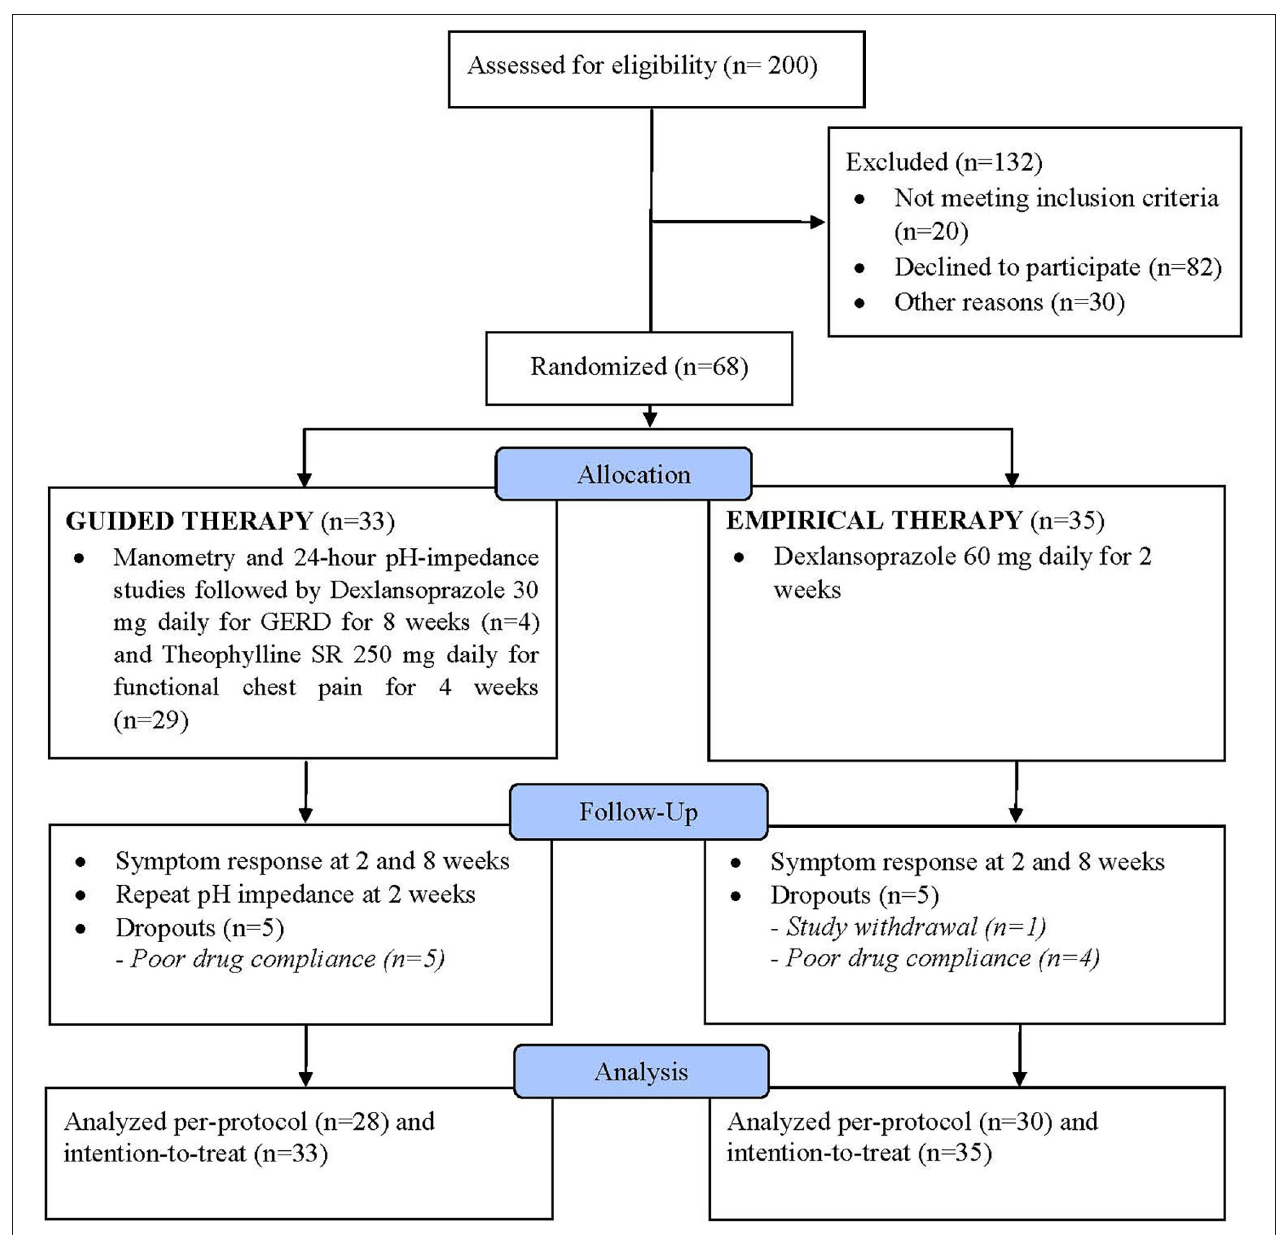
FIGURE 1 | Flow chart of the study.